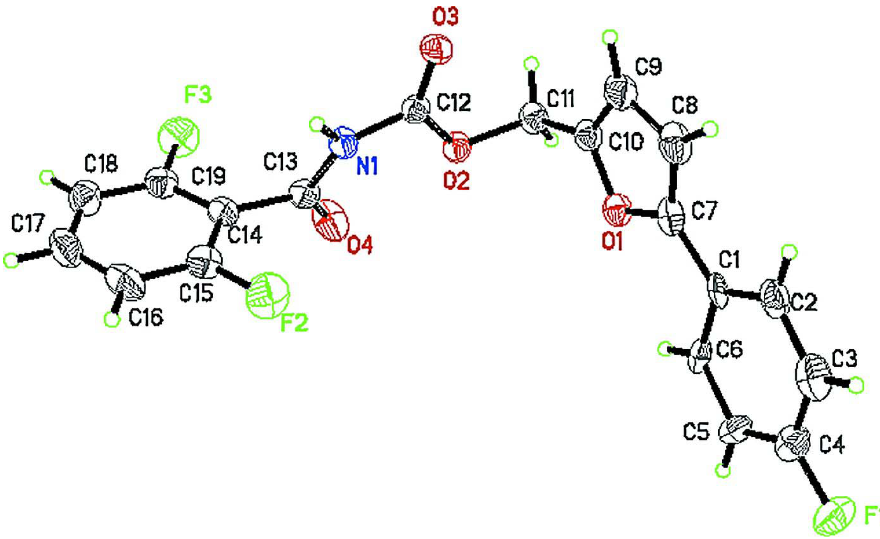
Figure 1 The molecular structure of (I), showing 40% probability displacement ellipsoids and the atom-numbering